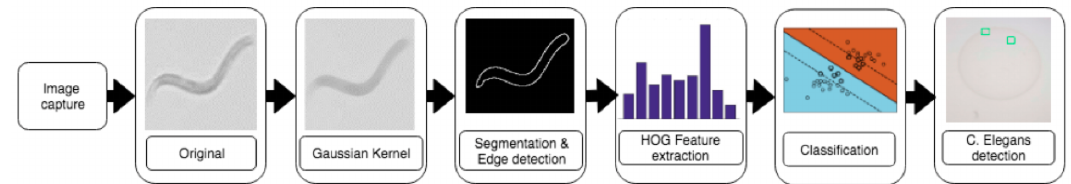
Figure 6. Applied image-processing toolchain for C. elegans detection.